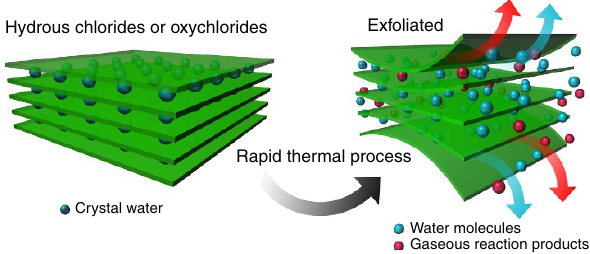
Figure 1 | Material synthesis. Schematic of the exfoliation of hydrous chlorides. During heating, large quantities of gas (water or other gaseous reaction products) are released. The force generated by gas generation and expansion leads to the exfoliation of the